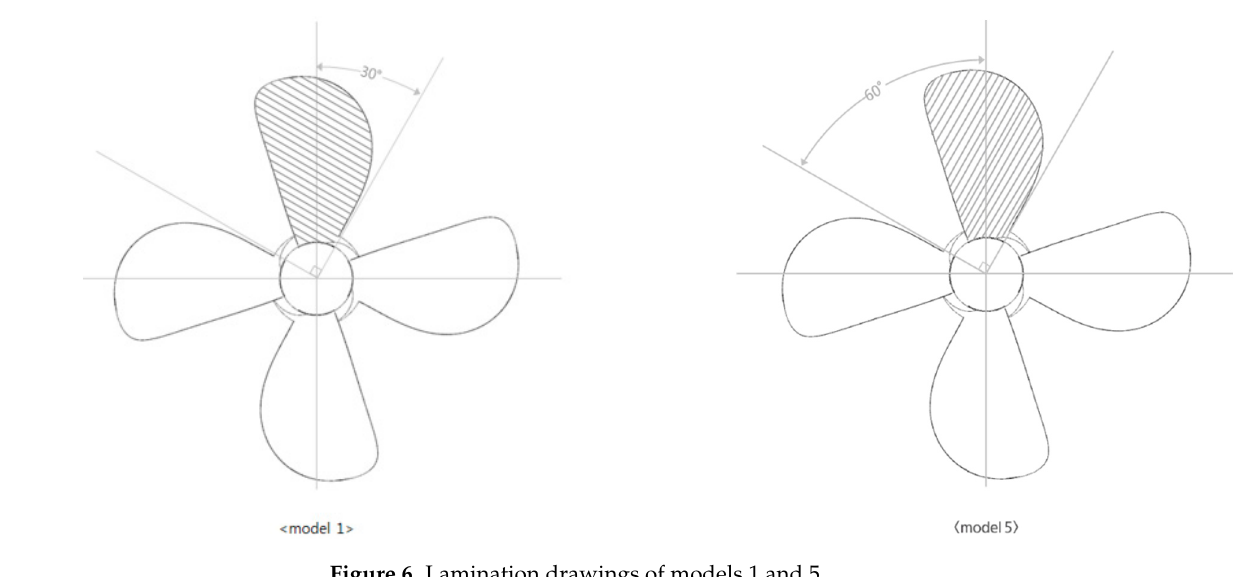
Figure 6. Lamination drawings of models 1 and 5.